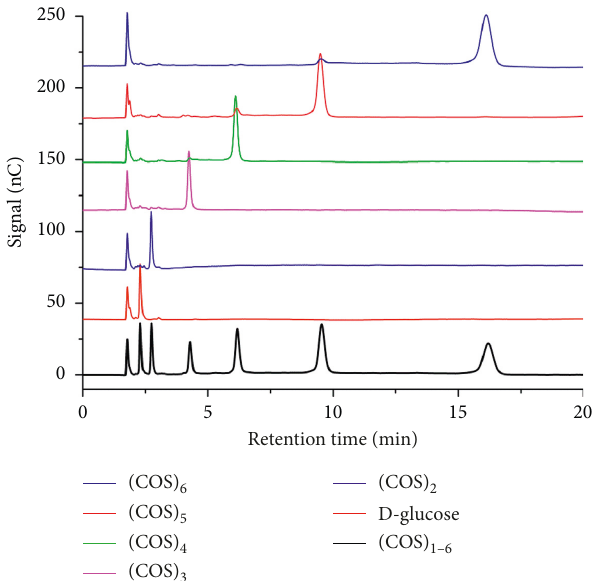
Figure 2: Typical HPAEC-PAD chromatograms of the mixed (COS) 1–6 standards on a CarboPacPA-100 column.